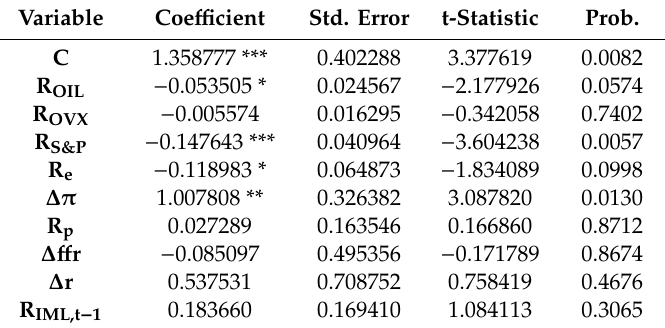
Table 10. OLS regression results (financial crisis).